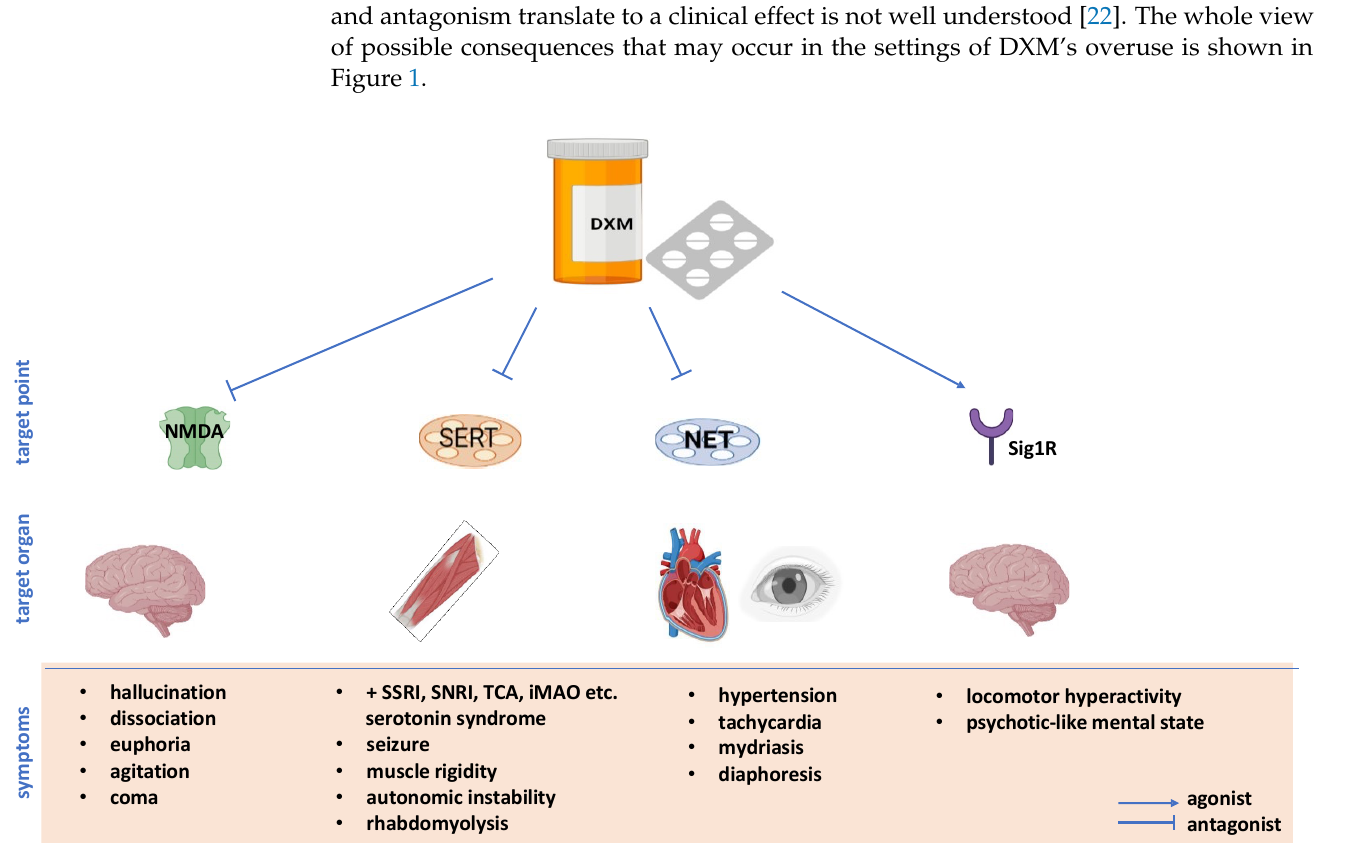
Figure 1. Dextromethorphan mechanisms of action and related side effects. Abbreviations: DXM— dextromethorphan; NMDA—N-methyl-d-aspartate (NMDA) receptors; SERT—serotonin trans- porters; NET—noradrenaline transporters; Sig1R—sigma-1 receptors; α3β4N—alpha3-beta-4 nico- tinic (nACh) receptors; SSRI—selective serotonin reuptake inhibitors; SNRI—noradrenaline reuptake inhibitors; TCA—tricyclic antidepressants; iMAO—monoamine A inhibitors. Desired action and side effects are presented on an either white or red background, respectively. Created with BioRender.com.